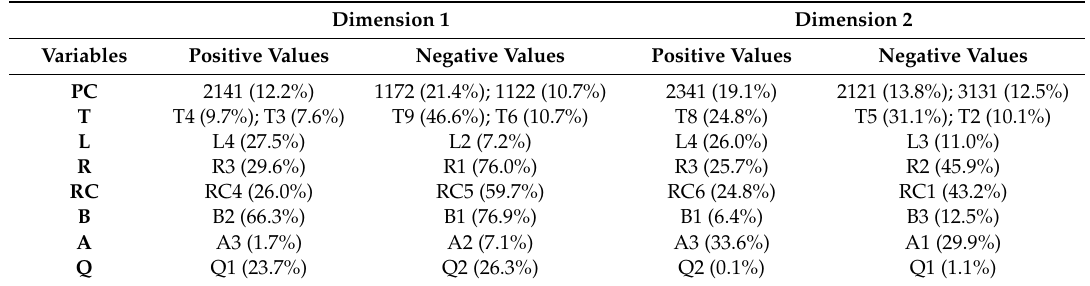
Table 11. Quantifications of the most representative categories of the